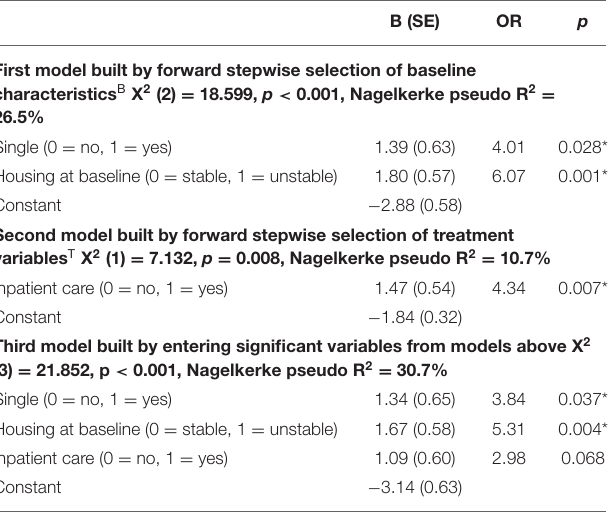
TABLE 4 | Logistic regression models with correlates of housing at